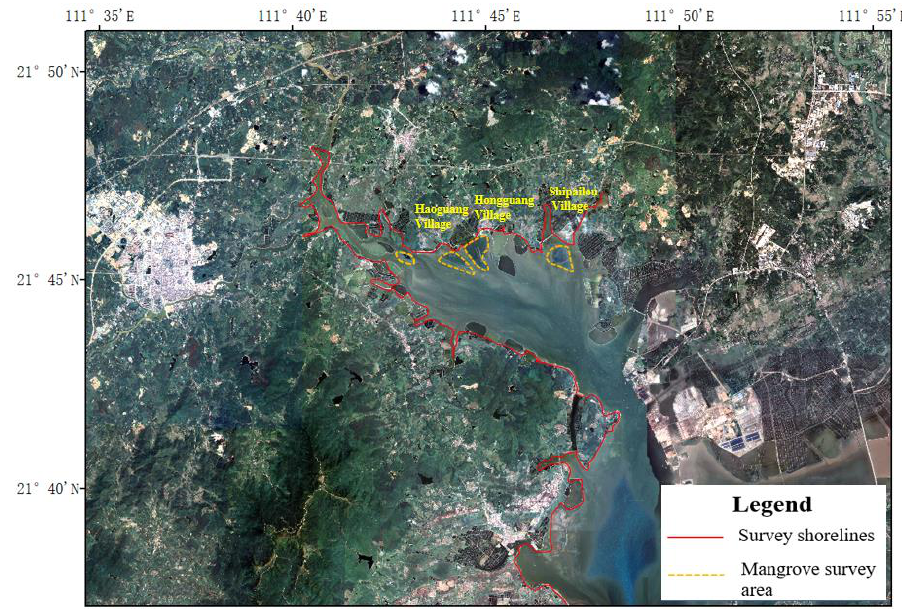
Figure 2. Geographic location of the survey shorelines and survey plots.